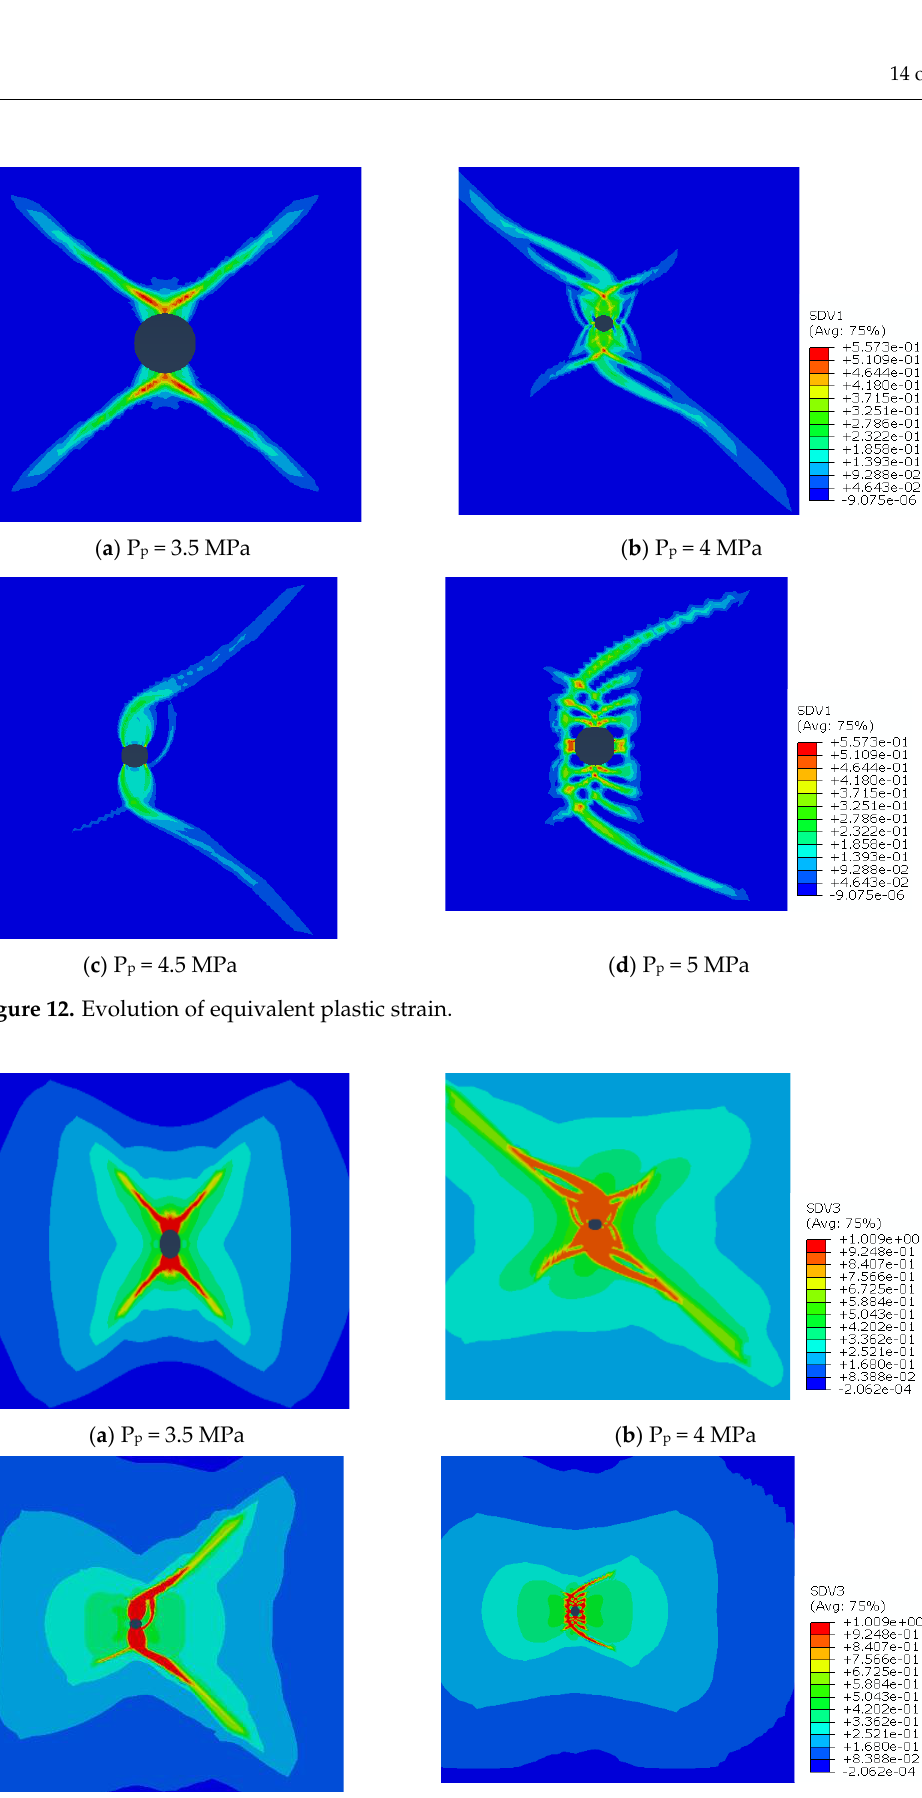
( b ) Disturbance damage factor ( c ) Plastic deformation ( d ) Node extraction path Figure 11. Variation of rock permeability, damage factor, and equivalent plastic strain with different distance. 4.4. Effect of Borehole Pressure During drilling, the drilling fluid within the borehole generates hydrostatic pressure on the borehole wall and causes compression stress on the borehole wall. The effect of the borehole pressure of 3.5 MPa, 4 MPa, 4.5 MPa, and 5 MPa on borehole instability is simu- lated.